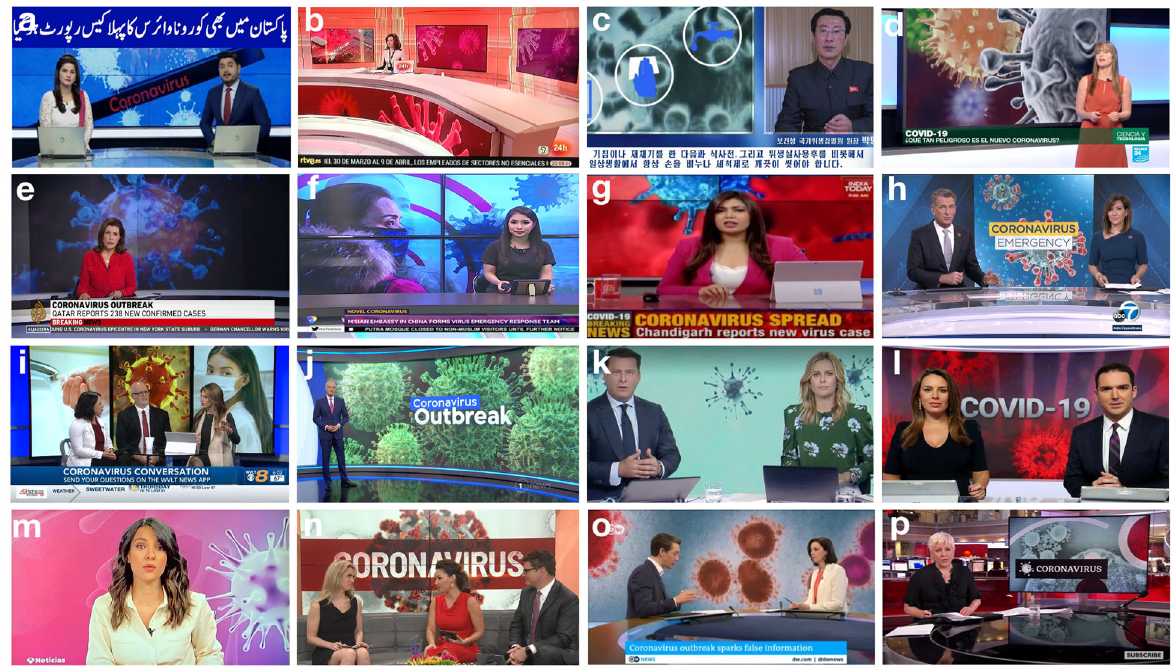
Fig. 3 Several television news programs with stage design and illustrations of SARS-CoV-2. a – m Fake coronavirus models or other viruses, n a scienti fi c illustration, o , p real photos with retouched colour. Sources: a K21 News, Pakistan, b Canal 24horas RTVE, Spain, c Central Korea TV show, North Korea, d News in Spanish, France24, France, e News in Al Jazeera, Qatar, f NTV7, Malaysia, g News on India Today, India, h Local news in ABC, USA, i News in Channel 8 in CBS/MyNetwork TV, USA, j News in Nzdt, New Zealand, k Today this morning, Channel 9, Australia, l Sky News, Australia, m Antena 3 Noticias, Spain, n 8 Wish-TV, USA, o Deutsche Welle, Germany, p BBC News, UK. This fi gure is not covered by the Creative Commons Attribution 4.0 International License. Reproduced with permission of Andreu-Sánchez and Martín-Pascual; copyright © Andreu-Sánchez and Martín-Pascual, all rights